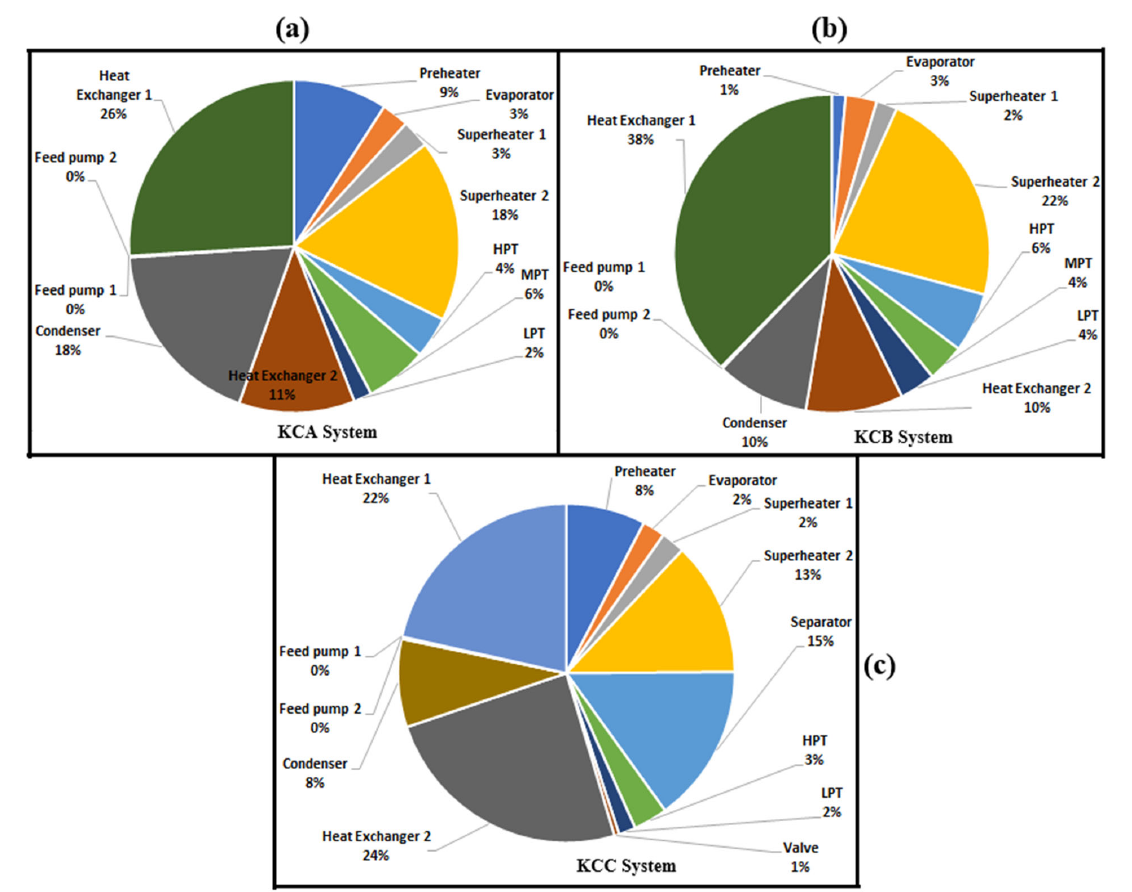
Figure 3. Exergy destruction rate of different components: ( a ) KCA, ( b ) KCB, and ( c ) KCC. The temperature versus entropy diagram for KCA, KCB, and KCC are presented in Figure 4A–C, respectively. The green line in subfigures A and B represents the saturation curve for an ammonia concentration of 0.88.